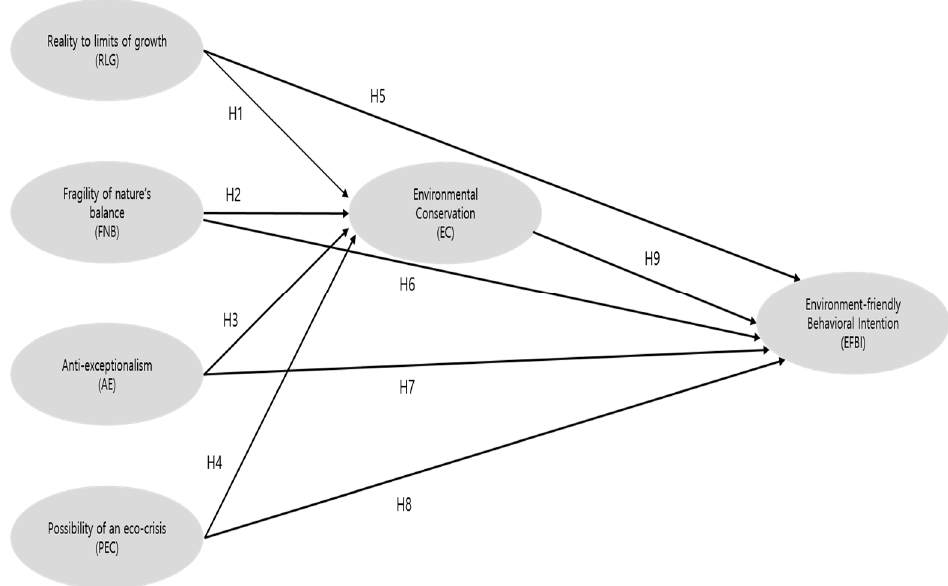
Figure 1. Conceptual model for hypotheses of the study. Note: H = hypothesis.